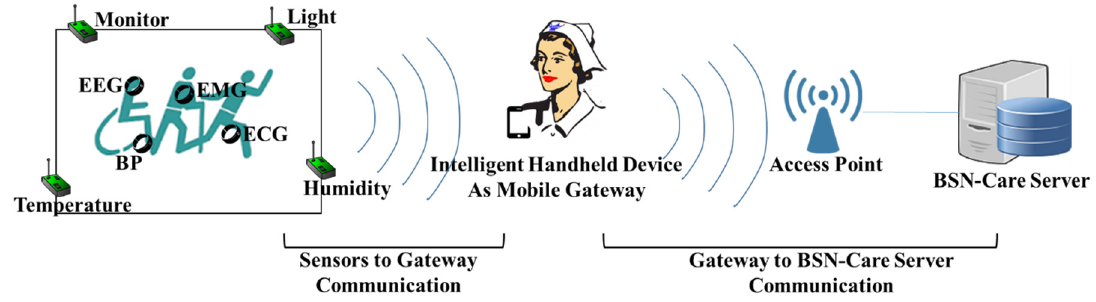
Figure 2. The proposed BSNCare+ system. EEG, electroencephalography; EMG, electromyography; BP, blood pressure; ECG, electrocardiography.